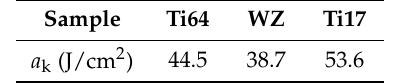
Table 3. Impact toughness of WZ and base metals.